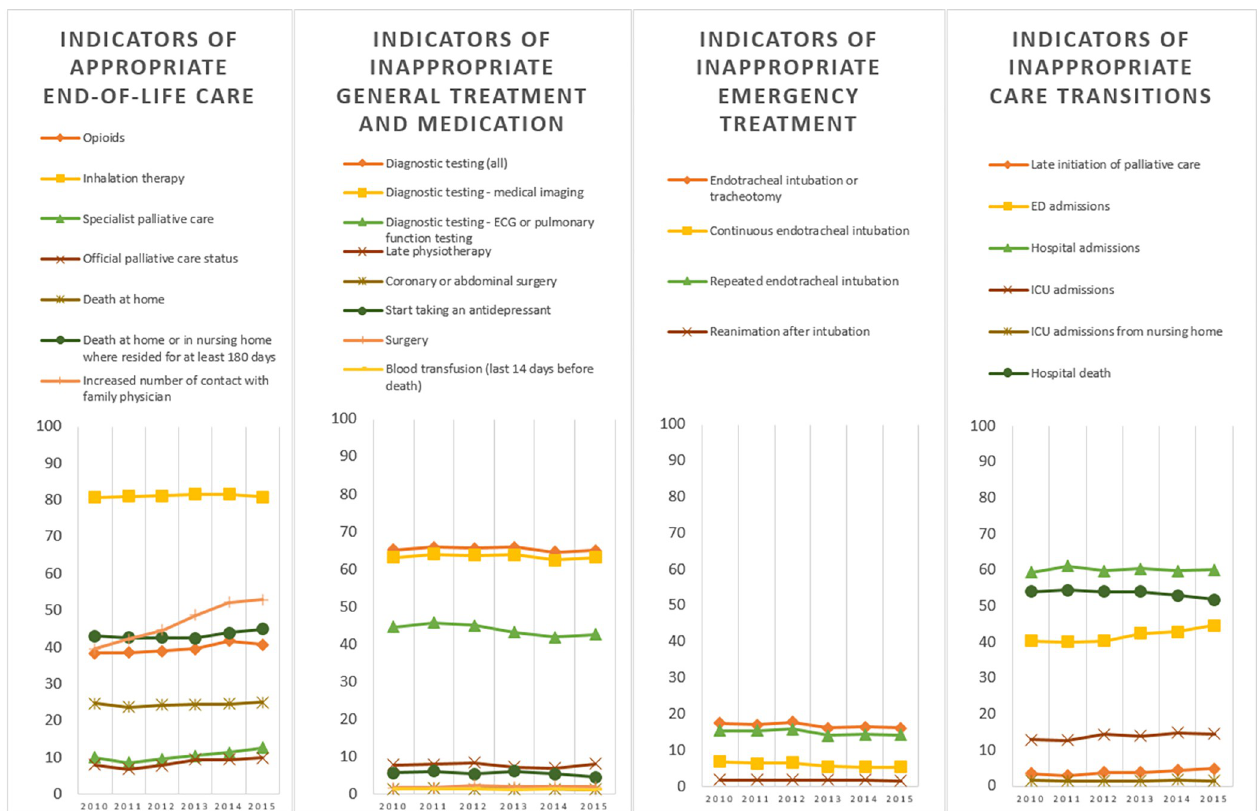
Fig 2. Trends in indicators of appropriate or inappropriate care in the last 30 days of life for people for people dying from COPD, thematically grouped. The Y-axis represents the risk adjusted percentage of the population that received the treatment or care specified for this quality